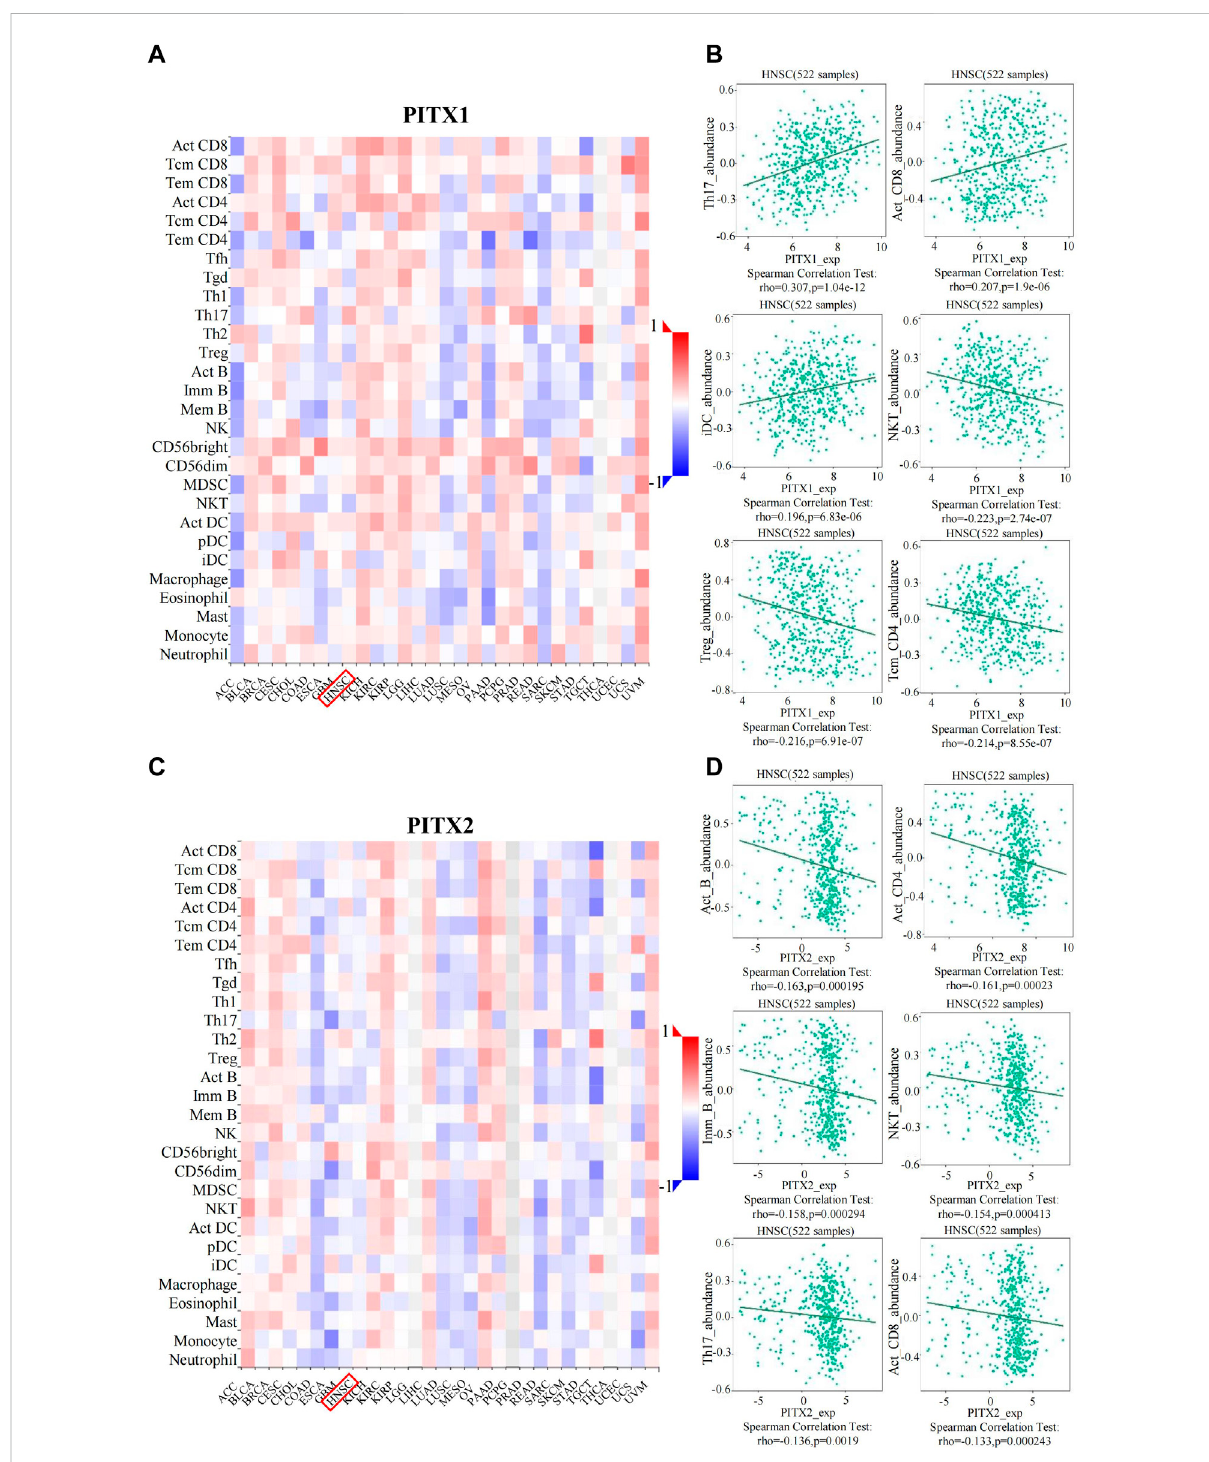
FIGURE 8 TISIDB analysis of correlations between PITX1 and PITX2 expression and immune cell in fi ltration across human cancers. (A) The relationship between PITX1 expression and 28 types of TILs across various human cancers. (B) The top six TILs displaying the strongest Spearman ’ s correlation with PITX1 expression in HNSC. (C) The relationship between PITX2 expression and 28 types of TILs across various human cancers. (D) The top six TILs displaying the strongest Spearman ’ s correlation with PITX2 expression in HNSC. Act_CD8, activated CD8 + T cells; Tcm_CD8, central memory CD8 + T cells; Tem_CD8, effector memory CD8 + T cells; Act_CD4, activated CD4 + T cells; Tcm_CD4, central memory CD4 + T cells; Tem_CD4,effectormemoryCD4 + Tcells;Tfh,Tfollicularhelpercells;Tgd,gammadeltaTcells;Th1,type1Thelpercells;Th17,type17Thelpercells; Th2, type 2 T helper cells; Treg, regulatory T cells; Act B, activated B cells; Imm_B, immature B cells; Mem_B, memory B cells; NK, natural killer cells; CD56 bright , CD56 bright NK cells; CD56 dim , CD56 dim NK cells; MDSC, myeloid derived suppressor cells; NKT, natural killer T cells; Act DC, activated dendritic cells; pDC, plasmacytoid DCs; iDC, immature DCs; Mast, mast